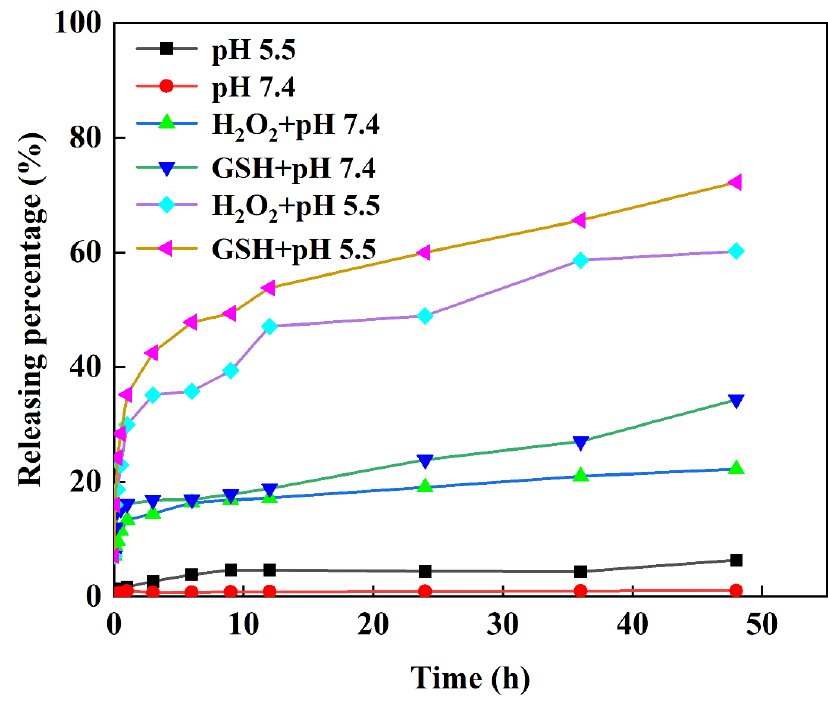
Figure 7. DOX release percentage from MXene-Se-DOX nanocarriers in different media.